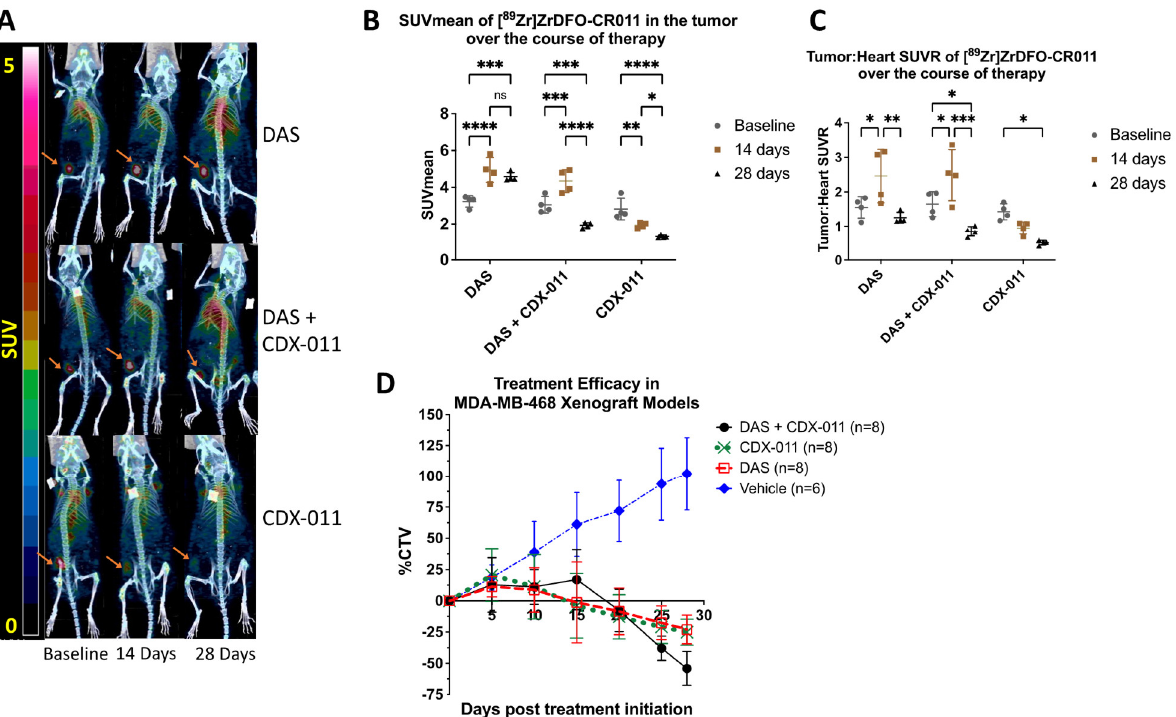
Figure 5. PET/CT imaging with [ 89 Zr]Zr-DFO-CR011 can monitor gpNMB expression in MDA-MB- 468 xenografted mice noninvasively over the course of treatment with dasatinib (DAS), CDX-011, or their combination. ( A ) Representative PET/CT images as maximum intensity projections from each treatment group over time (n = 4 per group). Arrows point to tumors. RapID ear tags are shown as white squares. ( B ) Quantification of [ 89 Zr]Zr-DFO-CR011 uptake in the tumor as SUV mean and ( C ) Tumor-to-Heart SUVR at baseline, 14, and 28 days post treatment initiation. * p < 0.05, ** p < 0.05, *** p = 0.005 **** p < 0.0005, ns is p > 0.05 ( D ) Change in tumor size measured as the percentage change in tumor volume (%CTV) relative to baseline after treatment initiation (n = 6–8 per group). Vehicle control vs. DAS p < 0.0001; Vehicle control vs. CDX-011 p < 0.0001; Vehicle control vs. DAS + CDX- 011 p < 0.0001; DAS vs. CDX-011 p = 0.9996; DAS + CDX-011 vs. CDX-011 p < 0.05; DAS + CDX-011 vs. DAS p < 0.05.